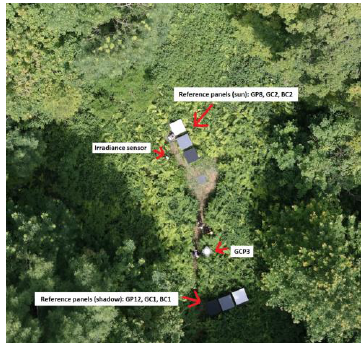
Figure 3. Terrestrial reference data during the UAV flights.